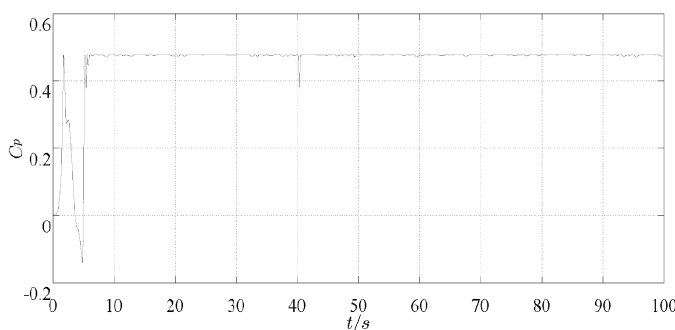
∗ after fault-tolerant control after fault-tolerant control. ref